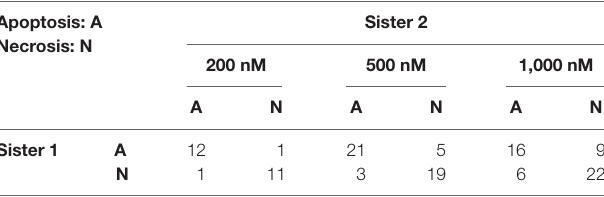
Table 1 | Number of observations of apoptotic- or necrotic-like cell death for sister cells exposed to YTX at concentrations 200, 500, and 1,000 nM. apoptosis: a necrosis: